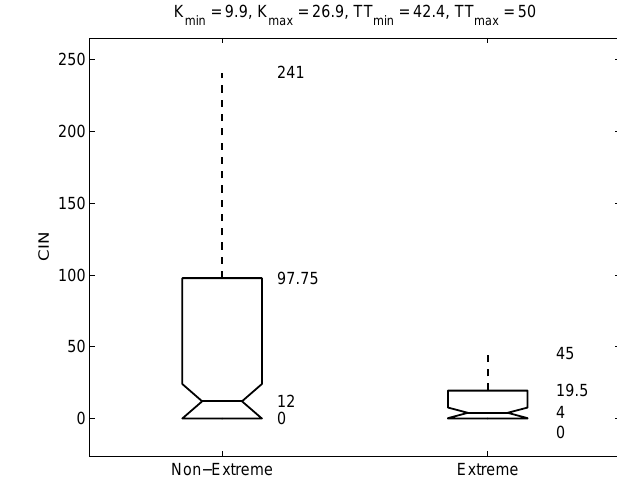
Fig. 3. The distribution of the values of the CIN index for the days where extreme (right) and non-extreme (left) events where extreme (right) and non-extreme (left) events occurred.